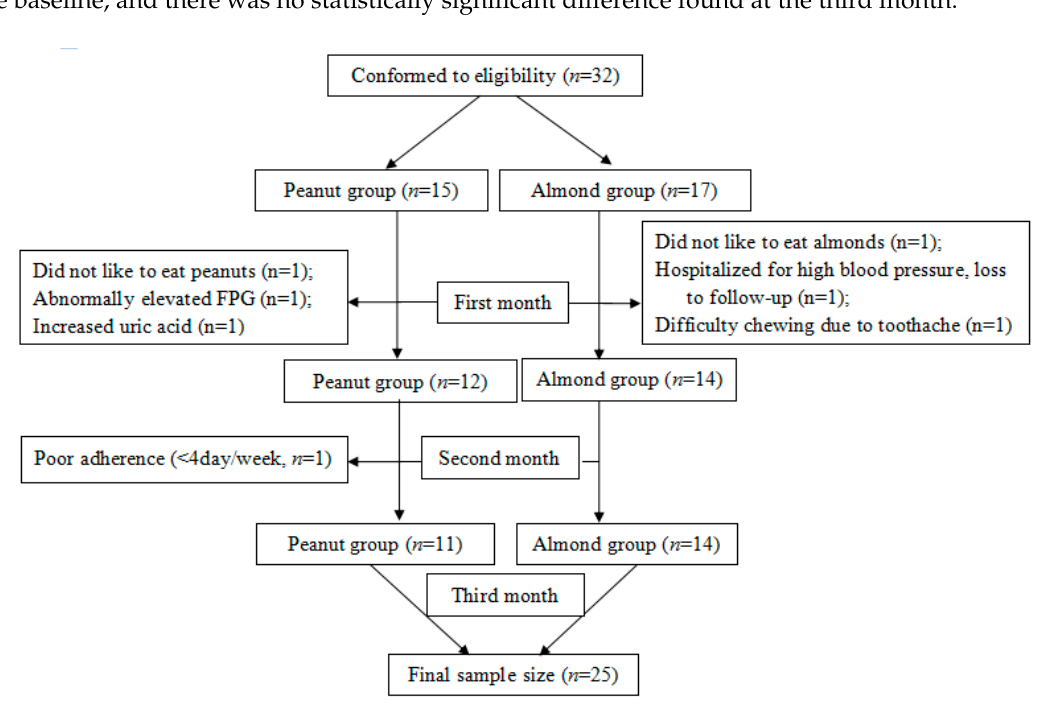
Figure 1. Flow diagram of the patients included in the study.